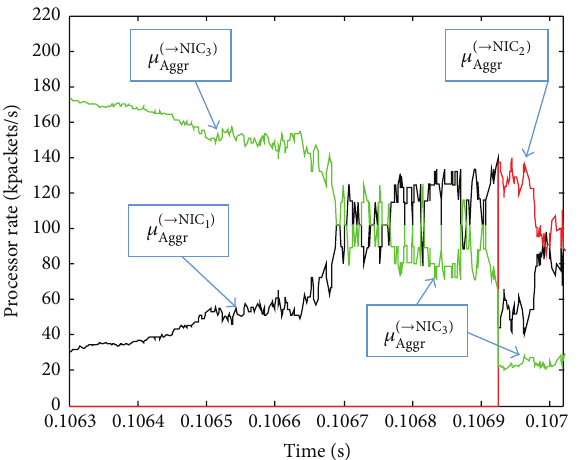
Figure 5: Packet rate assigned to the virtual queues.